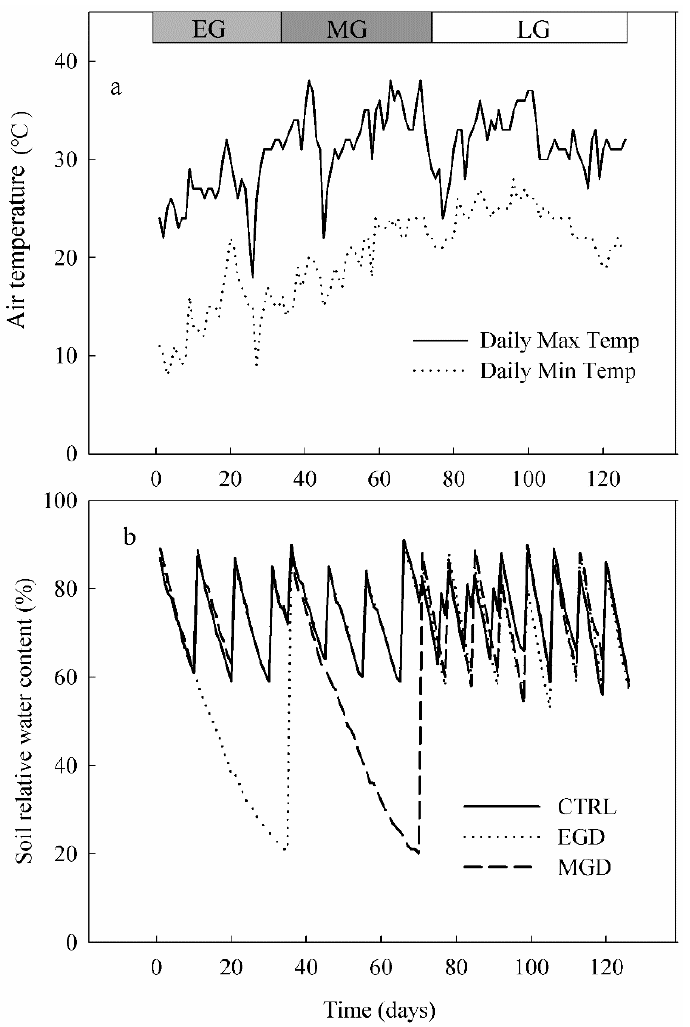
Figure 1. Air temperatures ( a ) and soil relative water content ( b ) during the experiment that started on April 26. CTRL indicates the control; EGD and MGD indicate the drought stress treatment in the early- (EG, days 0–35) and mid- (MG, days 36–70) growing season, respectively. LG refers to the late growing season (days 71–126). Time indicates days from the beginning of the experiment.